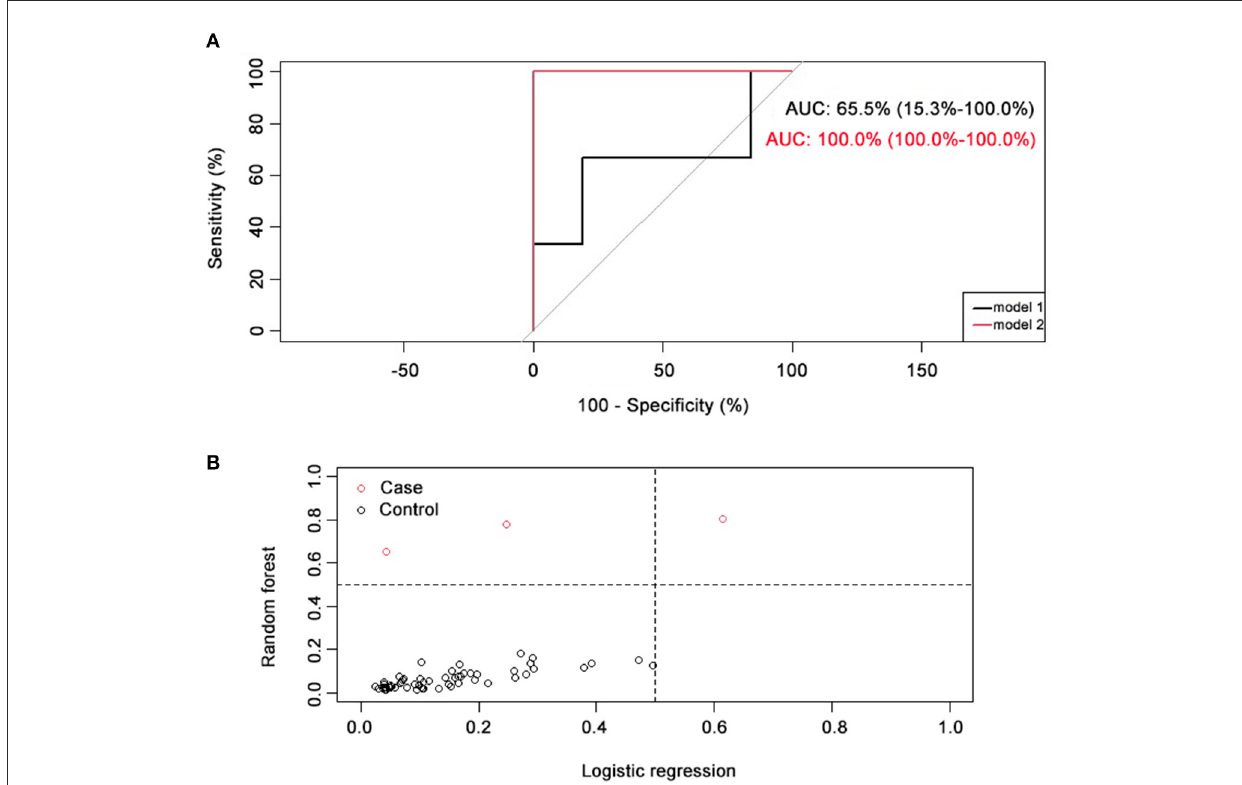
FIGURE2 Comparison of two prediction models. (A) ROC curve comparison of two prediction models. AUC for logistic regression model (model 1, black) was 65.5% (15.3 ∼ 100.0%), and AUC for random forest model (model 2, red) was 100.0% (100.0 ∼ 100.0%). (B) Classification capacity of two